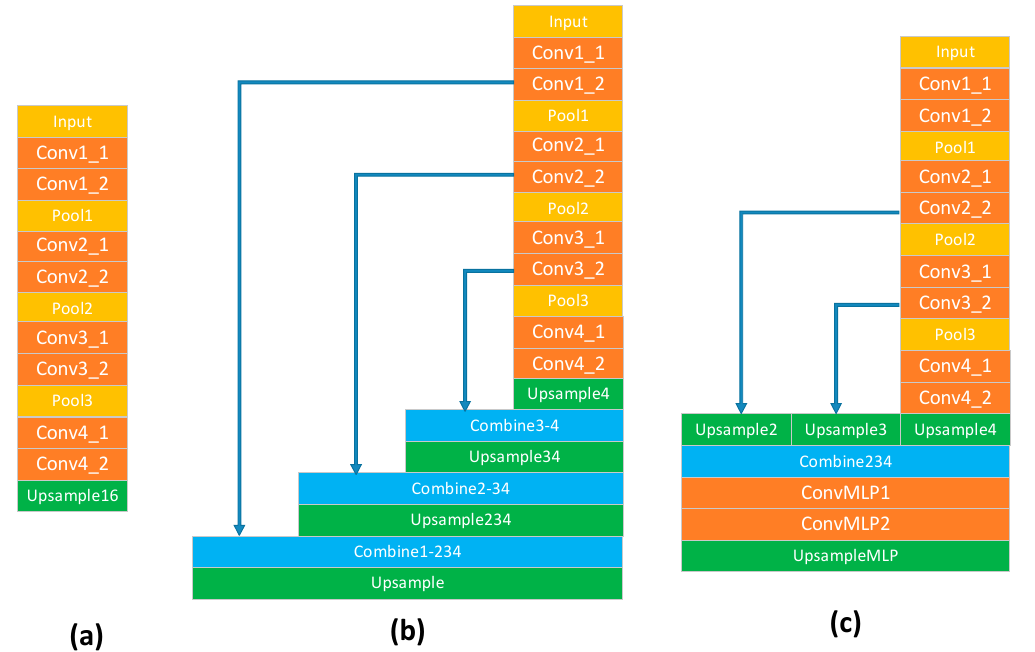
Figure 9. Network architectures of models we consider in a comparison of computational complexity.